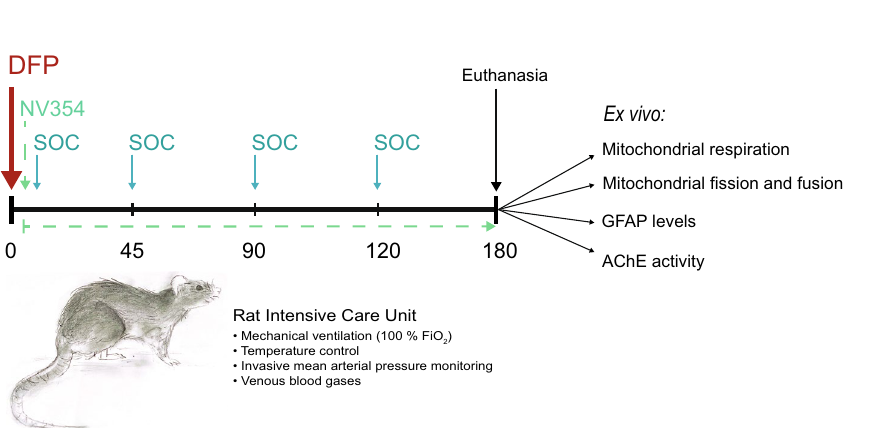
Figure 1. Study design. Once baseline was established, animals received either no treatment (Sham), an acute toxic dose of the organophosphate diisopropylfluorophosphate alone (DFP), DFP and standard of care (SOC) treatment (DFP + SOC), DFP, SOC treatment and the cell-permeable succinate prodrug NV354 (DFP + SOC + NV354) or DFP and treatment with the cell-permeable succinate prodrug NV354 (DFP + NV354). Mean arterial pressure and venous blood gases were measured throughout the experiment. DFP was administered at 3 mg/kg as single, intravenous bolus dose to simulate an acutely toxic one-time exposure. SOC, a combination of atropine (2 mg/kg) and pralidoxime (20 mg/kg), was given as intravenous bolus injections at 5 min following DFP exposure and repeated every 45 min until the end of the experiment. The succinate prodrug NV354 was given immediately after injection of DFP as a single, intravenous bolus dose at 17 mg/kg, followed by continuous venous infusion at 25 mg/kg/h until the end of the experiment. At the end of the experiment (180 min), the animals were euthanized, and brain tissue was immediately collected for ex vivo assessment of mitochondrial respiration, mitochondrial fission and fusion markers, Glial Fibrillary Acidic Protein (GFAP) levels and acetylcholinesterase (AChE)